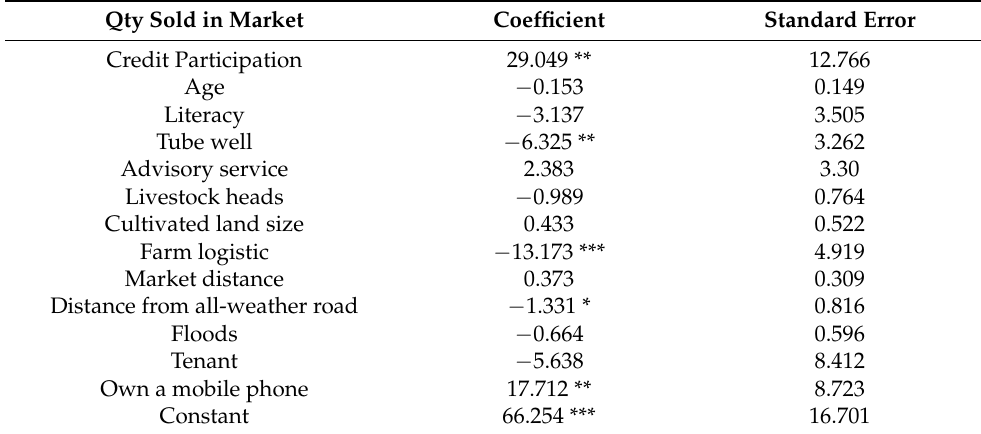
Table A7. Full table of OLS estimate of second-period credit and market